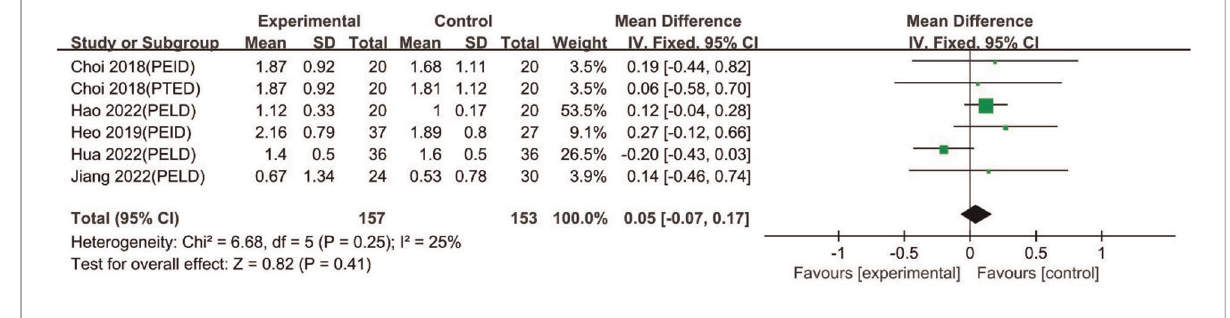
FIGURE 16 Forrest plot of long term vas leg pain UBE vs PELD.